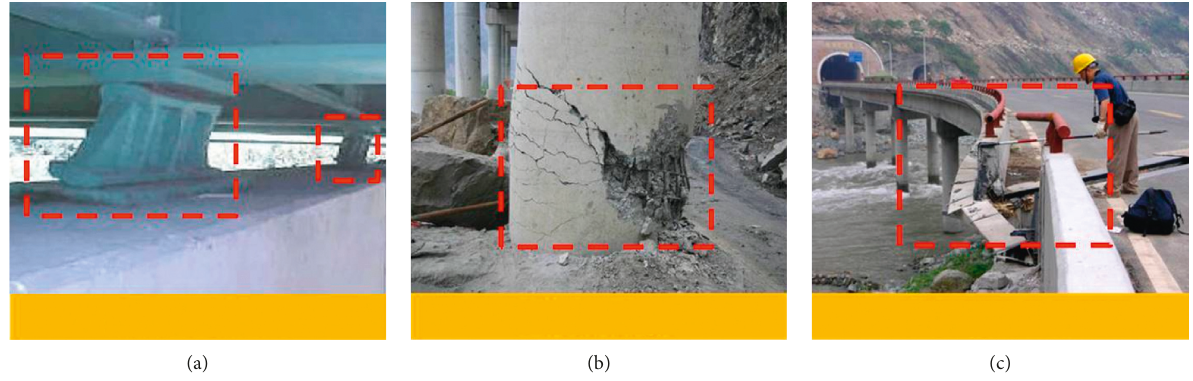
Figure 2: Seismic damage of bridge: (a) support failure; (b) pile breakage; (c) bridge pier